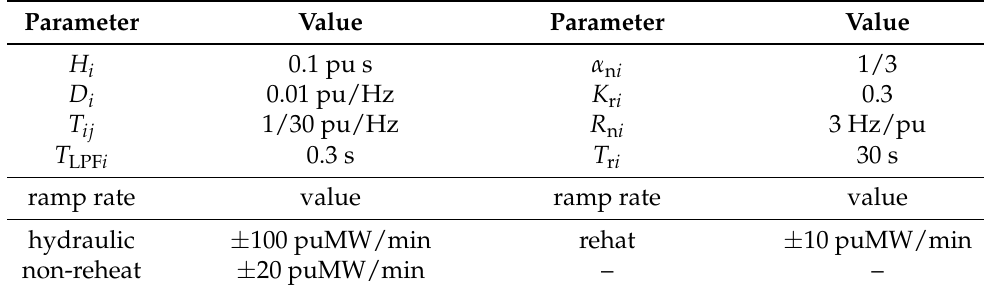
Table 1. Parameter values for a three-CA test system.